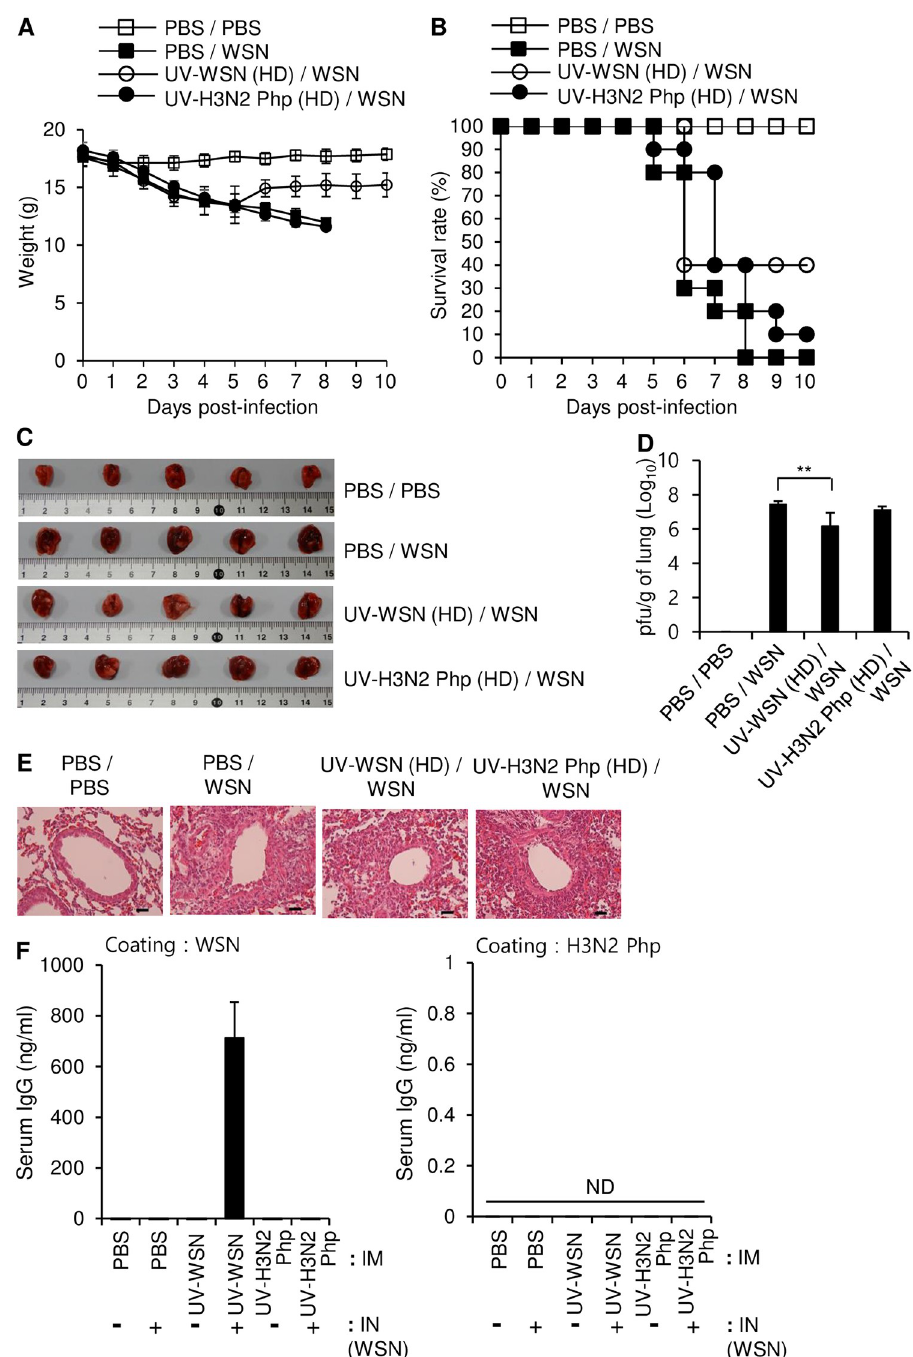
Fig 4. Intramuscular inoculation with a high dose of UV-inactivated virus provided partial protection against challenge with live virus. BALB/c mice were intramuscularly inoculated with 5 × 10 7 pfu of UV-inactivated Influenza A/WSN/1933 (UV-WSN) or UV-inactivated Influenza A/Philippines/2/1982 (UV-H3N2 Php). After 14 days, the mice were challenged intranasally with 10 LD 50 of live Influenza A/WSN/1933 (WSN). (A, B) Survival (A) and body weight (B) were measured for 10 days after the intranasal challenge (n = 10/group). (C–F) Lungs and sera were collected 5 days after the intranasal challenge (n = 5/group). (C) Lungs were evaluated macroscopically. (D) The viral load in the lungs was measured by plaque assay. (E) Paraffin-embedded lung sections were stained with H&E. Scale bars: 25 μ m. (F) The amounts of WSN-specific (left) and H3N2 Php-specific (right) total IgG in the sera were determined by ELISA (n = 5/group). ND, not detected. �� p <